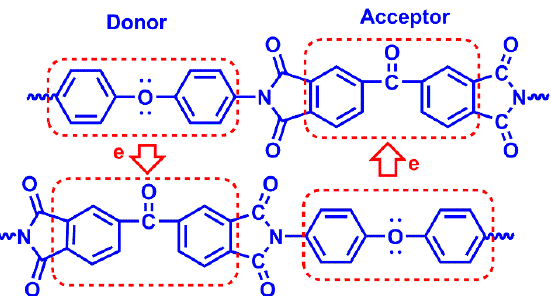
Figure 2. The schematic of intra ‐ and intermolecular charge transfer complexes (CTC).